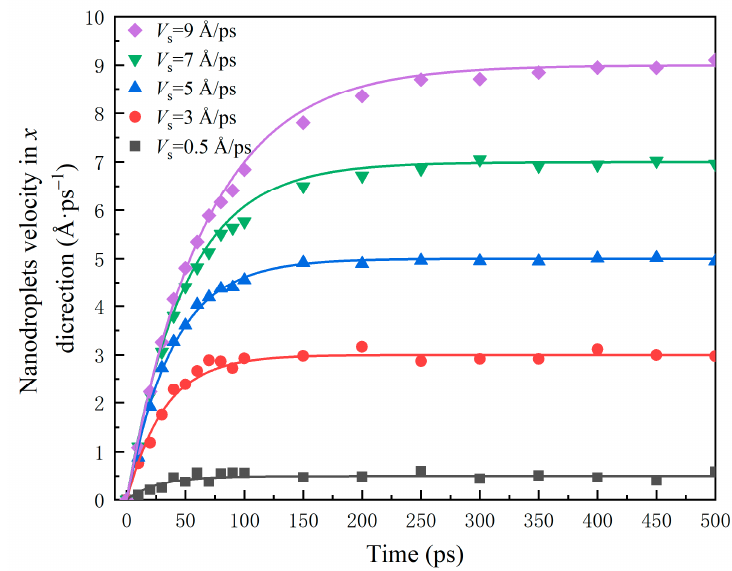
the V s direction and spreads. Contact angle hysteresis refers to the difference between the advancing contact angle θ a and the receding contact angle θ r . The extent of hysteresis experiences a gradual drop to zero as time passes, which means the contact angle hysteresis eventually disappears. The water nanodroplet spreads asymmetrically in x and y direc- tions at time t = 40 ps, and the asymmetry becomes more significant as time elapses. In particular, the water nanodroplet evolves into an ellipsoid at t = 80 ps. Afterwards, the water nanodroplet gradually recovers the sphere shape under the action of surface tension and then moves alongside the surface. The evolution of velocity of the water nanodroplet in the x direction, V x , is shown in Figure 5. It can be seen that the variation of V x can be divided into two stages: the relative sliding stage and the stable stage. At the relative sliding stage, the acceleration of V x increases with the surface velocity. Especially, during 0~50 ps, V x almost linearly increases with t . This is because the deformation of water nanodroplets becomes more severe with the increase in surface velocity, making the spreading area enlarged, and thus the interaction between droplets and surfaces is enhanced. Once the water nanodroplet reaches the maximum spreading state, it begins to retract, and the interaction becomes weakened, resulting in a slowdown in the acceleration of V x . At a stable stage, the translation velocity of the water nanodroplet is roughly equal to that of the surface, and there is no relative sliding between them.